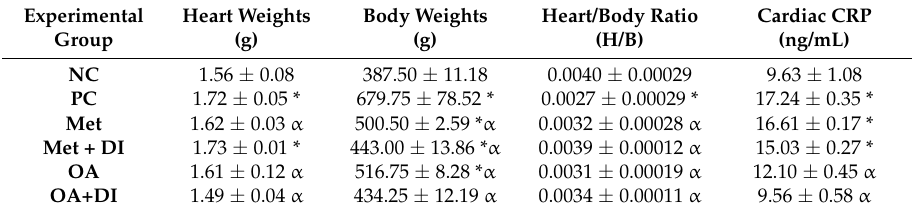
Table 1. Effects of OA and Met ( n = 6, per group) on heart sizes, body weights and cardiac CRP of rats that continued with HFHC diet. Values are presented as standard error of mean ± SEM. Non ‐ pre ‐ with dietary intervention (Met + DI), oleanolic acid treated (OA) and oleanolic acid treated with dietary intervention (OA + DI).